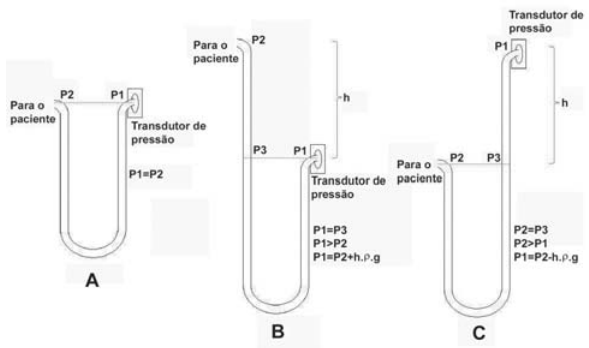
Fig.1 - A. Circuito de medição de pressão com extremidade para o transdutor de pressão e para o paciente no mesmo nível. B. Extremidade do transdutor mais baixa que o paciente. C. Extremidade para o paciente mais baixa que o transdutor de pressão (P = pressão, h = altura, ρ = densidade do líquido, g = aceleração da